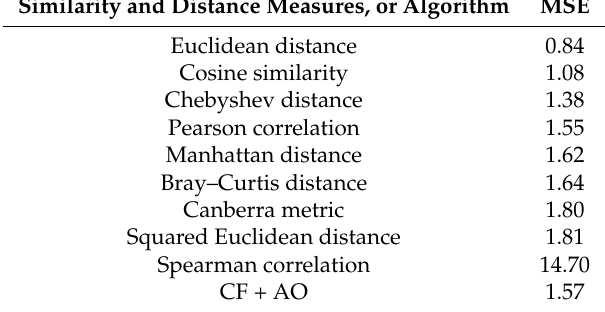
Table 10. MSE of the nine similarity and distance measures concentrated in the user-based CF algorithm and of user-based CF with an average aggregation operator that integrates five similarity and distance